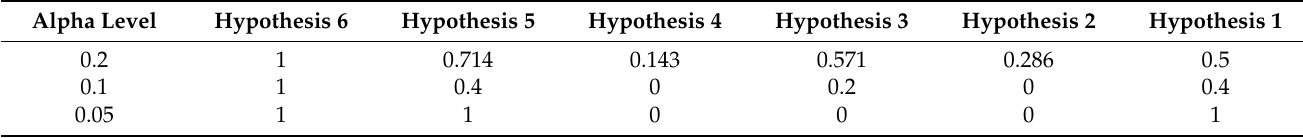
Table 4. Proportion of all hypotheses including each of the six individual hypotheses significant at three alpha levels (0.05, 0.1, and 0.2) for the combined spatial–temporal niche partitioning